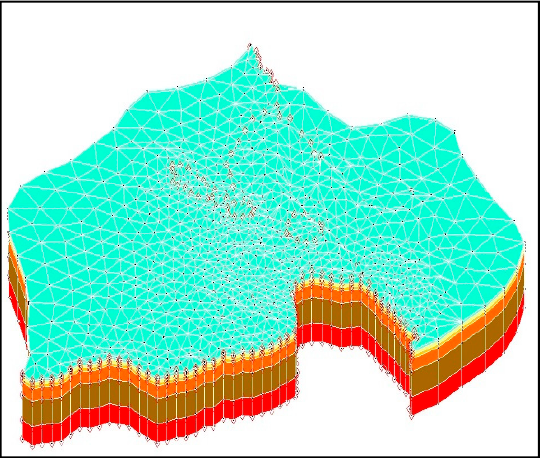
Figure 1. ( a ) A layout map of the Rum Jungle Mine site [33]. ( b ) A geological and mineral deposits map of the Rum Jungle Mine area [34].